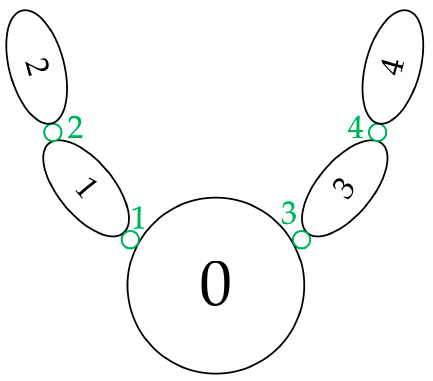
Figure 8. Schematic diagram of the topology of the satellite platform. The black numbers represent the body number and the green numbers represent the joint number.